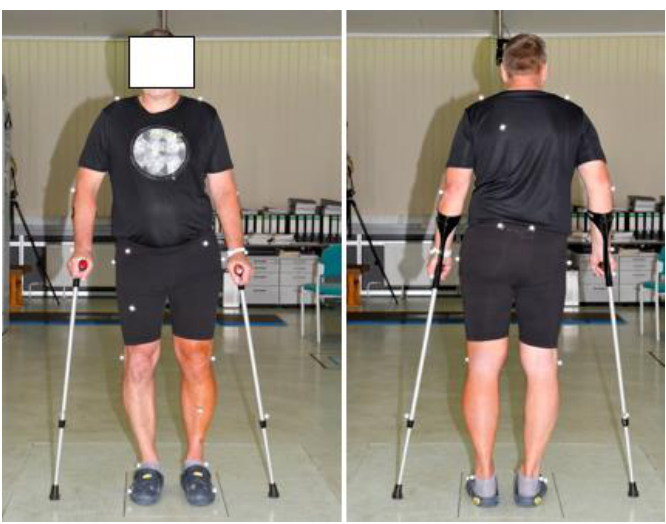
Figure 3. A patient with markers. A whole-body model was used to record the upper body movement in addition to the lower